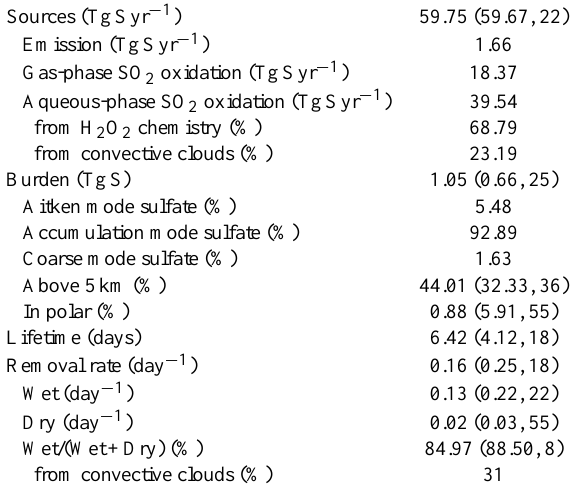
Table 2. Global annual budget for sulfate. The values in the paren- thesis are the mean value (left) and normalized standard deviation (right, as percentage) from available models in AeroCOM (see Tex- tor et al., 2006, Table 10). The standard deviation is normalized by the all models average in the percentage in AeroCOM.